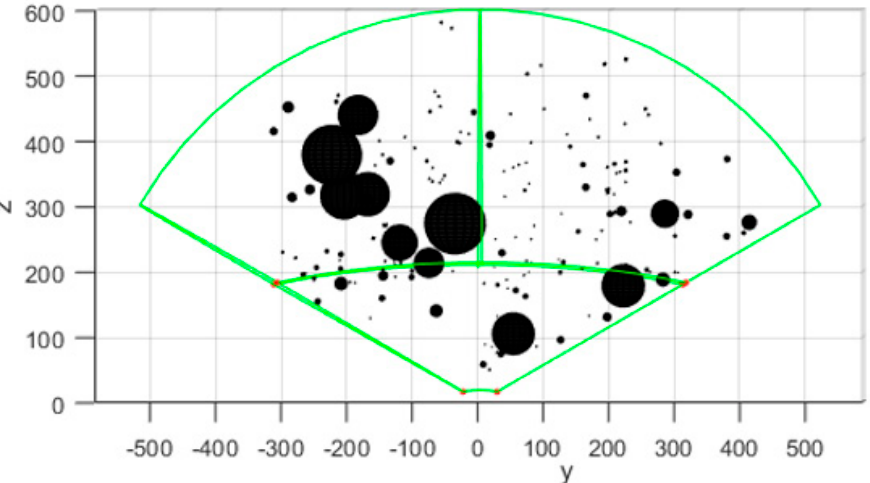
Figure 8. Up to 60 cm: side view. Z and y axis are in mm.